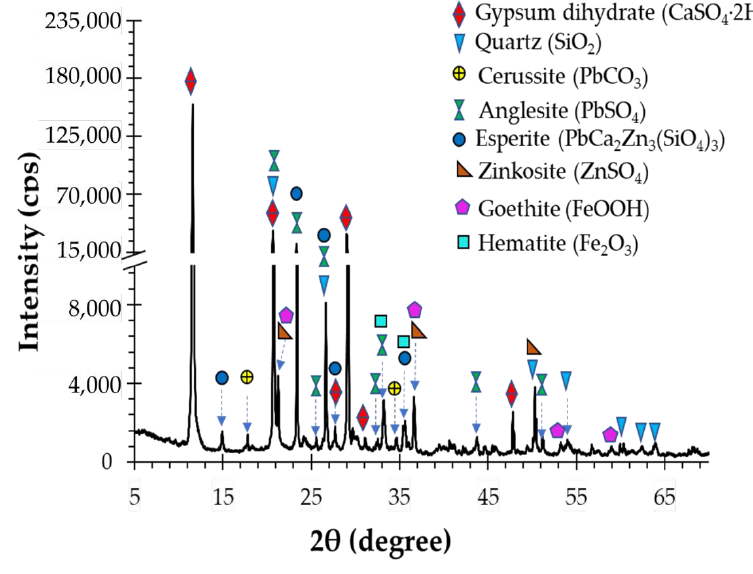
Figure 2. XRD pattern of the zinc plant leach residues from Kabwe, Zambia.